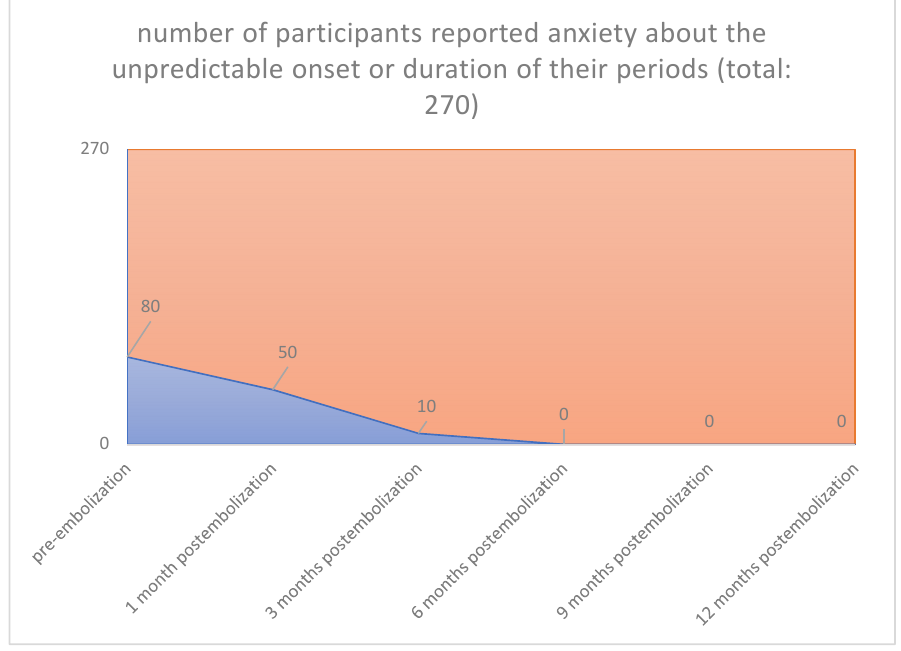
Figure 6. Anxious about the unpredictable onset or duration of your periods: Pre-embolization 80 from 270 participants reported anxiety about the unpre-dictable onset or duration of their peri- ods. 1 Month 50 from 80 participants reported anxiety about the unpredictable onset or duration of their periods . 3 Months 10 from 80 participants reported anxiety about the unpredictable onset or duration of their periods. 6 Months 0 from 80 participants reported anxiety about the unpredictable onset or duration of their periods. 9 Months 0 from 80 participants reported anxiety about the un- predictable onset or duration of their periods. 12 Months 0 from 80 participants reported anxiety about the unpredictable onset or duration of their periods. An increase of sexual activity, a decrease in pressure or tightness in the pelvic area, absence of infection and pain, and an increase of libido over the last months after uterine embolization were also observed (125/270 [46.3%] vs. 0/270 [0%], p < 0.001) (125/270 [46.3%] vs. 0/270 [0%], p < 0.001) (115/270 [42.6%] vs. 0/270 [0%], p < 0.001) (135/270 [50.0%] vs. 0/270 [0%], p < 0.001) (Figures 7–10), respectively.